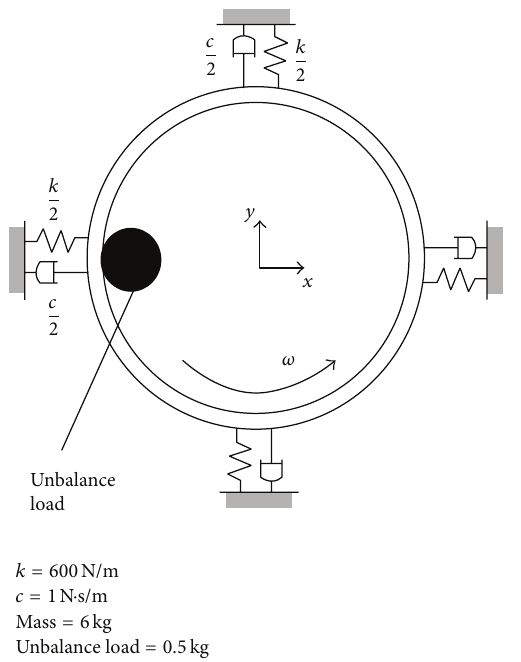
Figure 5: Schematic of 3 degrees of freedom (DoF) model.